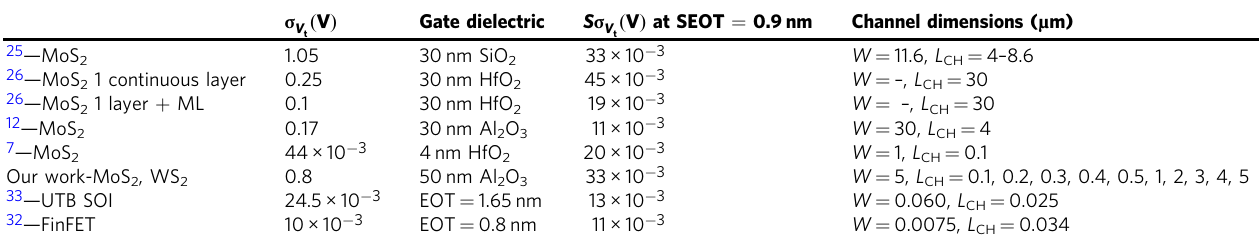
Table 1 Benchmarking device-to-device variation in threshold